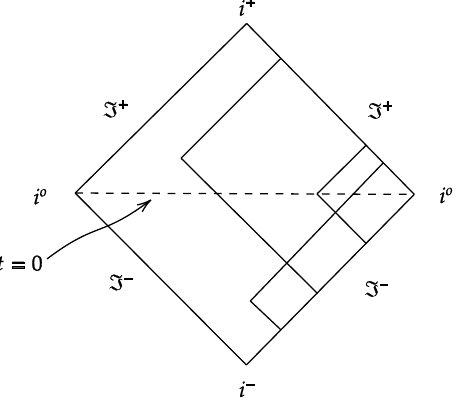
Figure 2: The basic idea of an asymptotic casual diamond, illustrated. We draw the 1 + 1 dimensional prototype here. If one views the x -coordinate as a radial coordinate together with a (cid:90) freedom (the angle degree of freedom in 1 + 1 d), this will turn 2 into a more conventional Penrose diagram. The local bulk aspects we discuss are invisible in this simple 1 + 1 dimensional situation. We show only ACDs attached to the right boundary